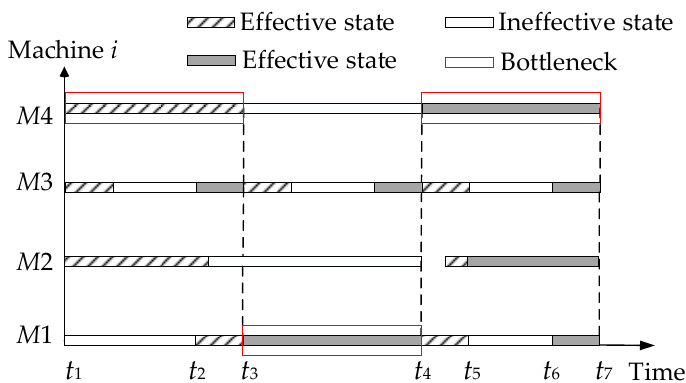
Figure 9. Example of subsystem bottleneck status.